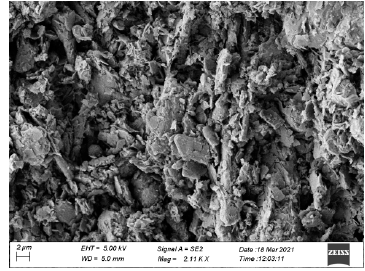
Figure 2. SEM image under 2 μ m scale.